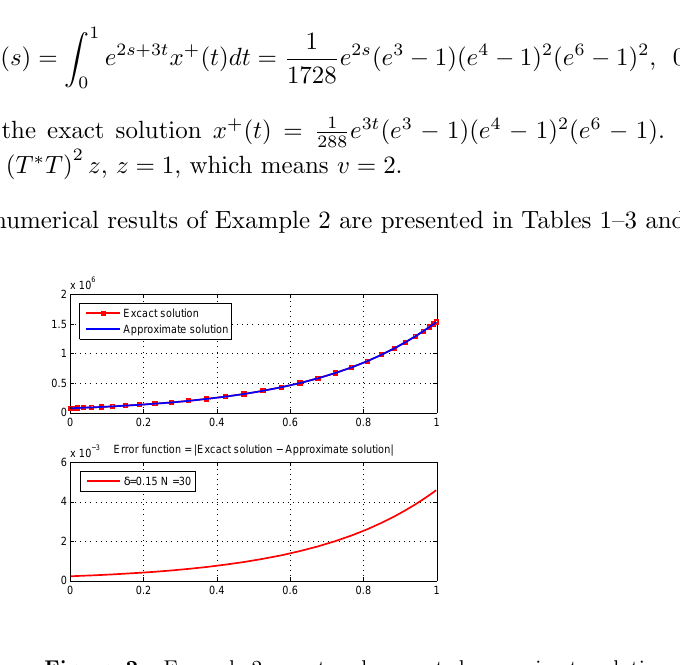
Figure 2. Example 2: exact and computed approximate solutions, absolute errors with n = 30 and noise level